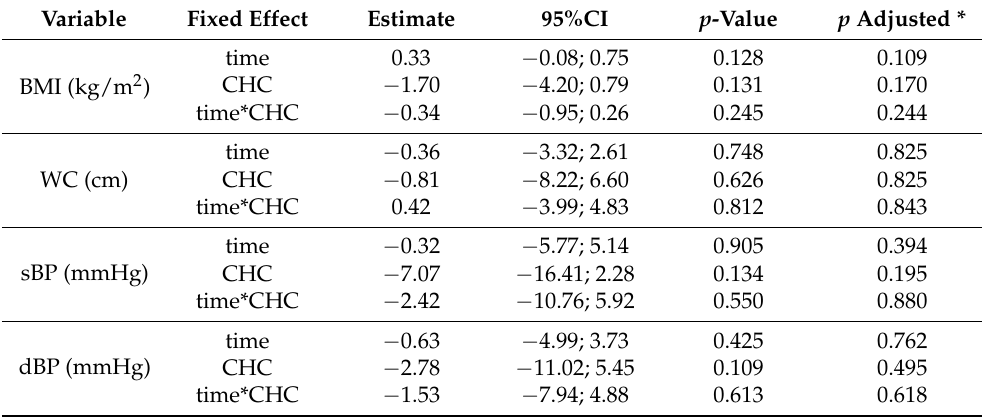
Table 2. Differences in the parameters of androgen secretion, glucose metabolism, lipid profile, and inflammation between the study groups. Analyses were performed with a linear mixed model with a random